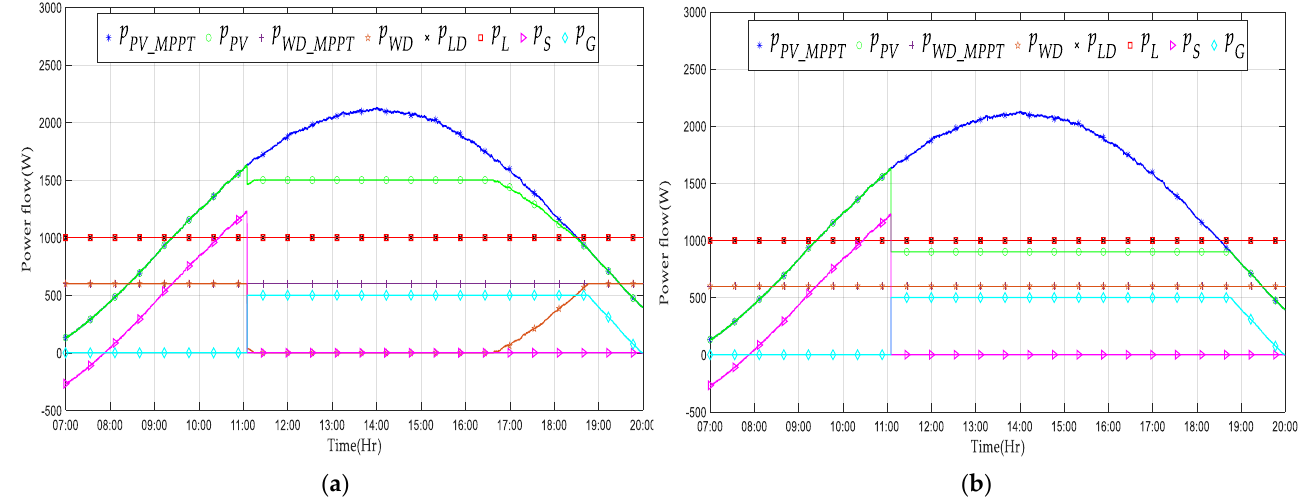
Figure 9. Power flow curves without optimization by applying the γ coefficient in the case of: ( a ) c PVS > c WDS ; ( b ) c PVS < c WDS .